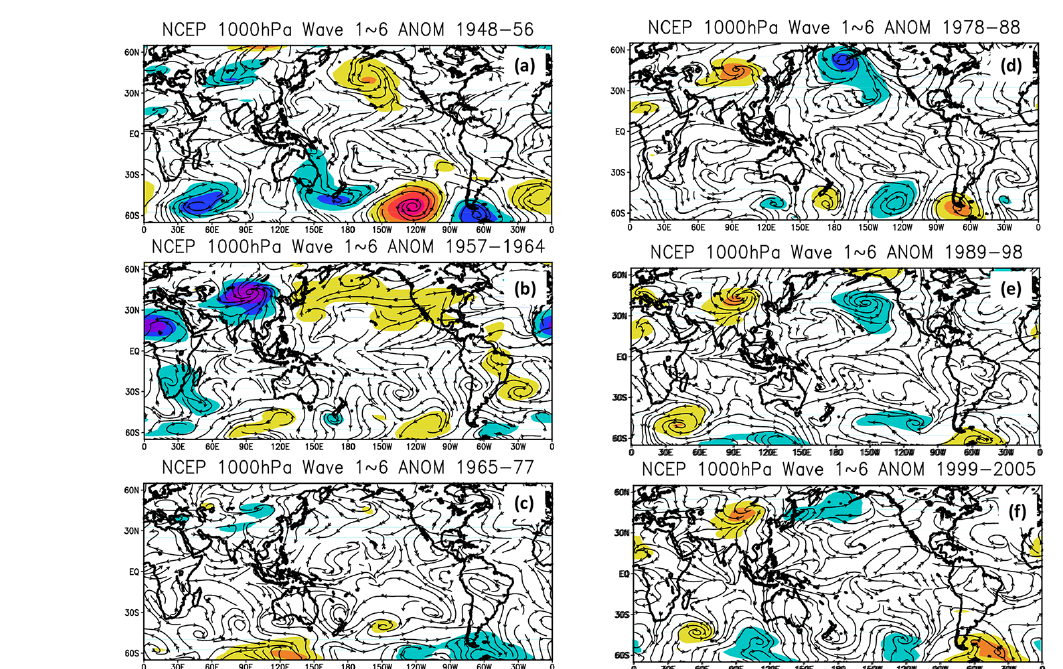
Figure 7. Global regime shift period reconstructed height (shaded) and wind field anomalies (streamlines) at 1000hPa model level for planetary wavenumbers 1 through 6. Shaded areas indicate height anomalies exceeding the significance tests at the 90% confidence level (negative anomaly: blue–purple shading; positive anomaly: green–yellow–red). (a) 1948–1956; (b) 1957–1964; (c) 1965–1977; (d) 1978– 1988, (e) 1989–1998, (f) 1999–2005. Note that the domain shown is from 60 ◦ S to 60 ◦ N.